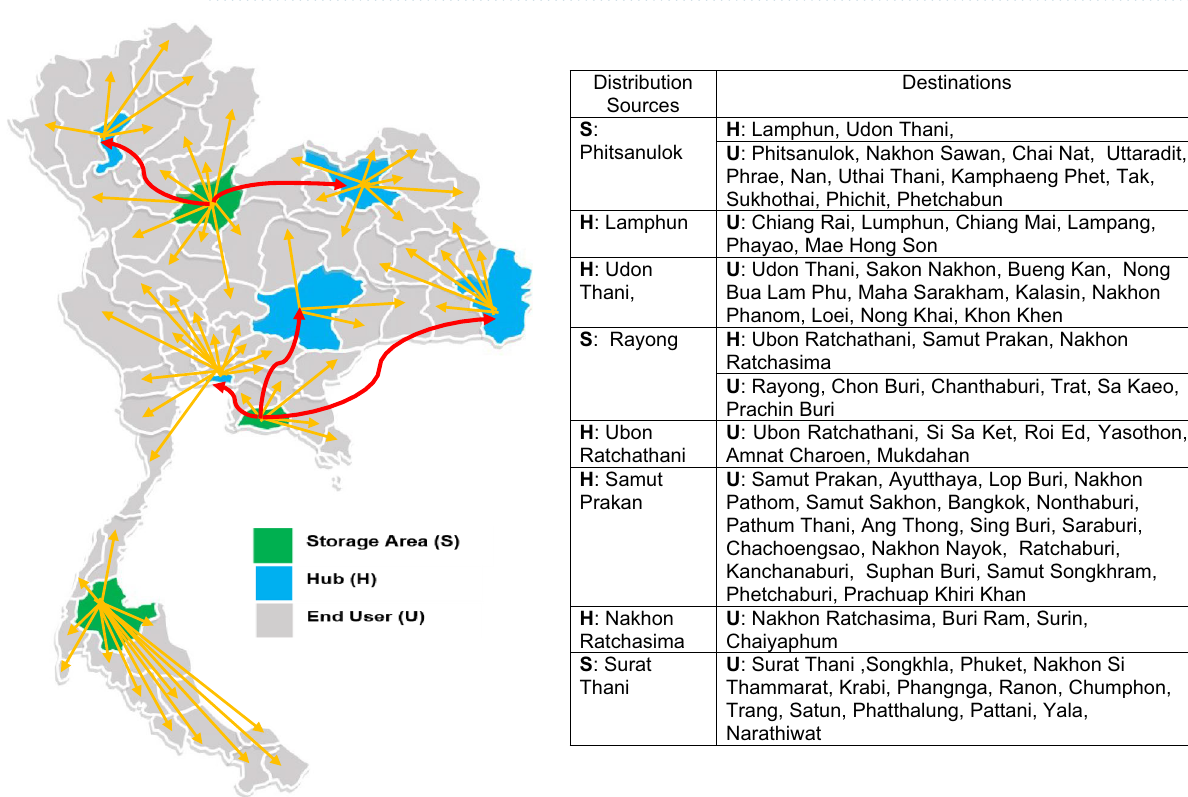
Figure 7. The location of facilities (storage areas or hubs) to their end users for scenario C on Thailand map created with Microsoft Office 365, Excel Version 1905 (https:// www. office. com/ launch/ excel?